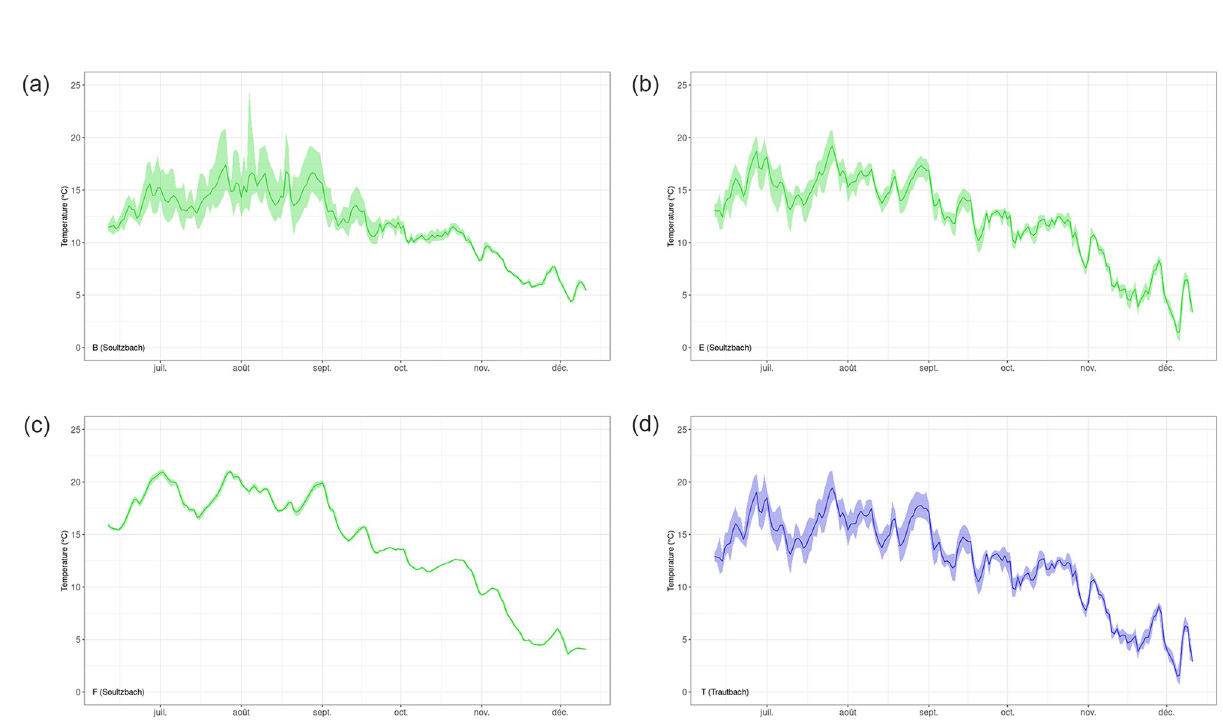
Fig 2. Surface water temperature time series during the study. Green: Soultzbach stream. Blue: Trautbach stream. Letters indicate monitoring stations (see Fig 1).